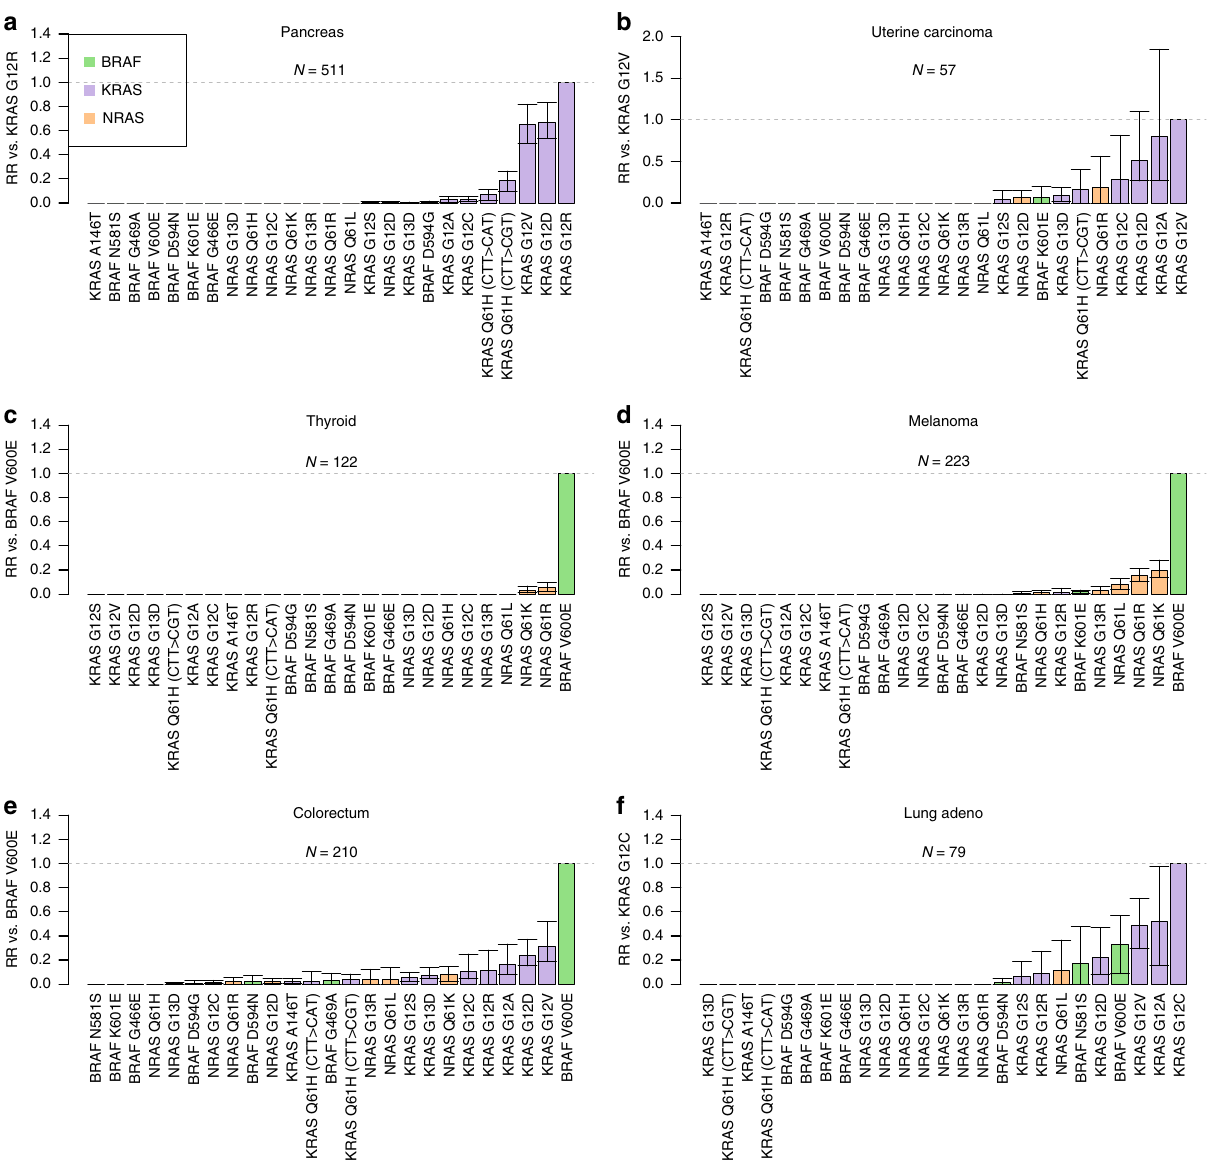
Fig. 4 Evidence for differential selection between mutations in KRAS , BRAF and NRAS. Bar plots show modelled relative risk of KRAS , BRAF , and NRAS mutations (compared with a reference mutation). a Modelled relative risk of KRAS , BRAF and NRAS , mutations compared to KRAS G12R in pancreatic cancer. b As above, with comparison to KRAS G12V mutations in uterine carcinoma. c As above, with comparison to BRAF V600E mutations in thyroid cancer. d As above, with comparison to BRAF V600E mutations in melanoma. e As above, with comparison to BRAF V600E in colorectum. f As above, with comparison to KRAS G12C in lung adenocarcinoma. Con fi dence intervals obtained by bootstrapping across 100 iterations. Error bars represent 95% con fi dence intervals obtained by bootstrapping across 100 iterations. N indicates total number of samples used for the analysis within each cancer